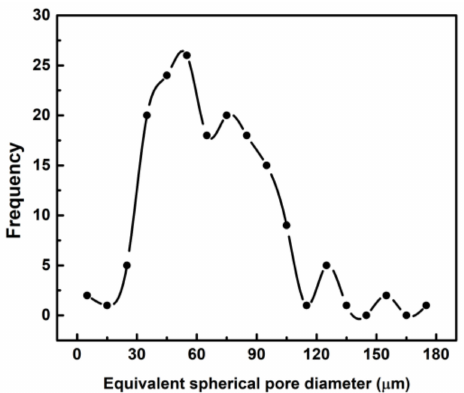
Figure 7. Histogram of the pore size distribution of the lyophilized PVP hydrogel determined by nano-CT analysis. Pore size is indicated as the equivalent spherical diameter of the pores observed in Figure